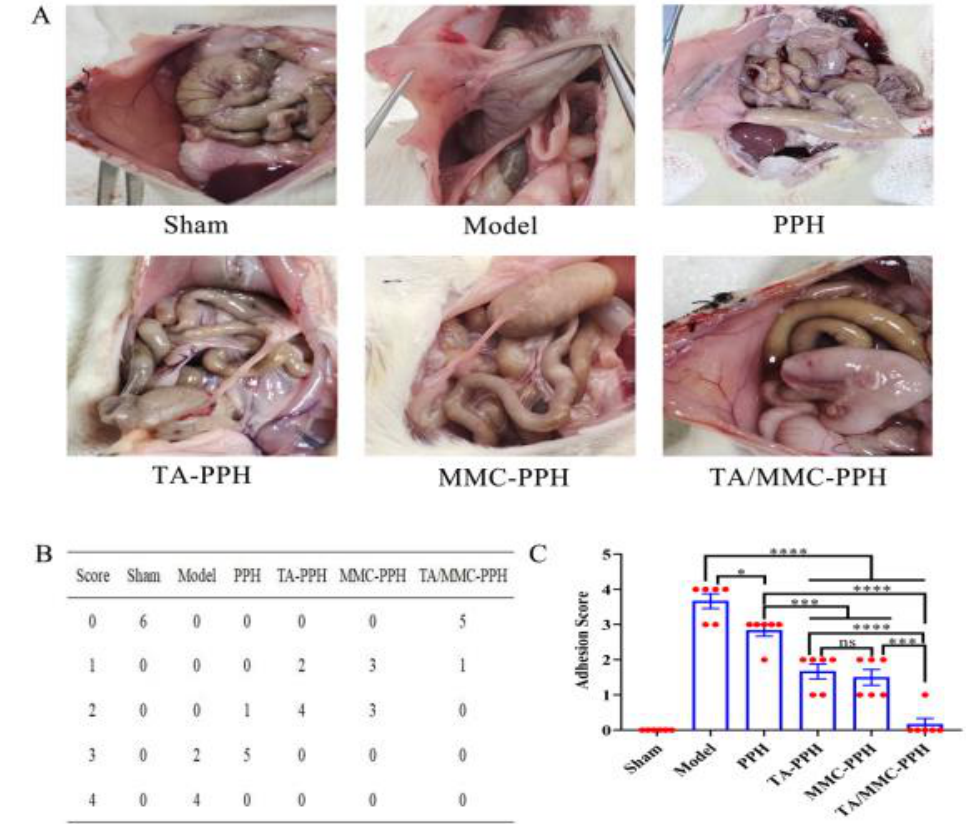
Figure 4. ( A ) Representative pictures of the formation of the abdominal adhesion between the abdominal wall and cecum in the sham-operated group, control group, PPH group, TA-PPH group, MMC-PPH group, and TA/MMC-PPH group at the beginning of the model establishment day 7 post-operation. ( B , C ) Adhesion scores of different groups after treatment on day 7 post-operation. ( n = 6, The red points in the figure represent the number of rats). The data are the mean ± standard deviation (SD) ( n = 3; * p < 0.05, ** p < 0.01, *** p < 0.001, **** p < 0.0001).